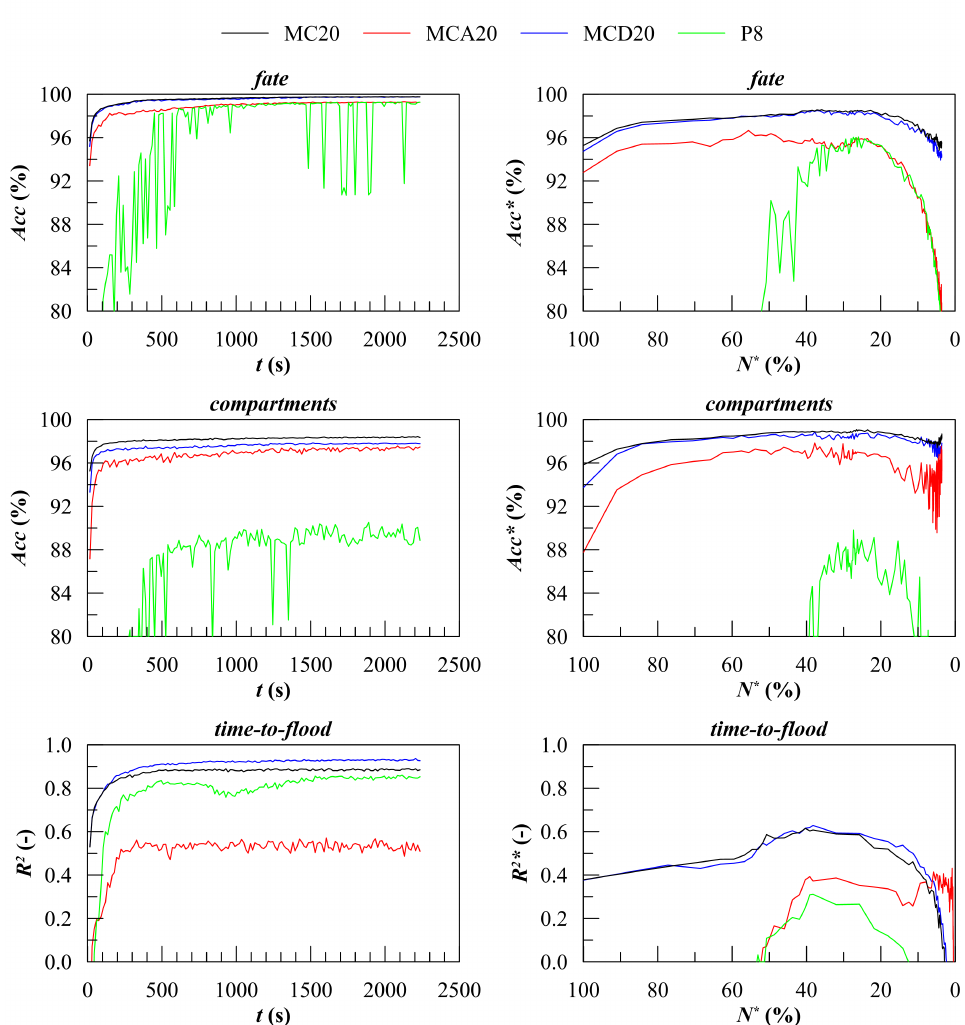
Figure 8. Comparison of the performances of the tested database-generation methods. Validation: MC50b; method: